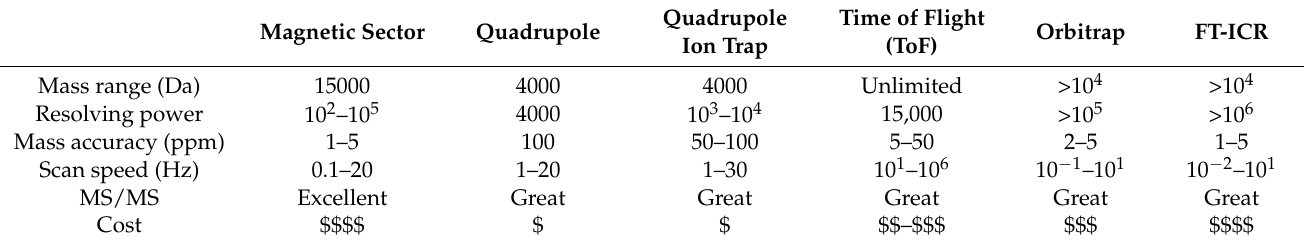
Table 3. Comparison of standard mass analyzers